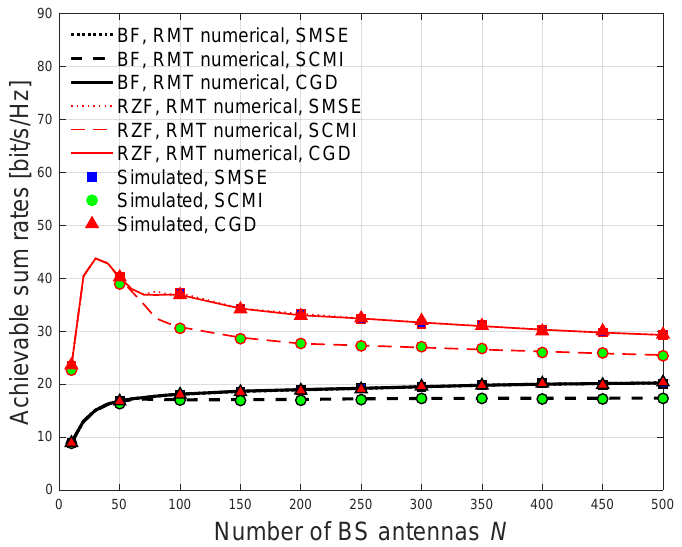
Figure 3. Achievable sum rate versus N , comparing different training designs with ω = 25 ◦ , D =